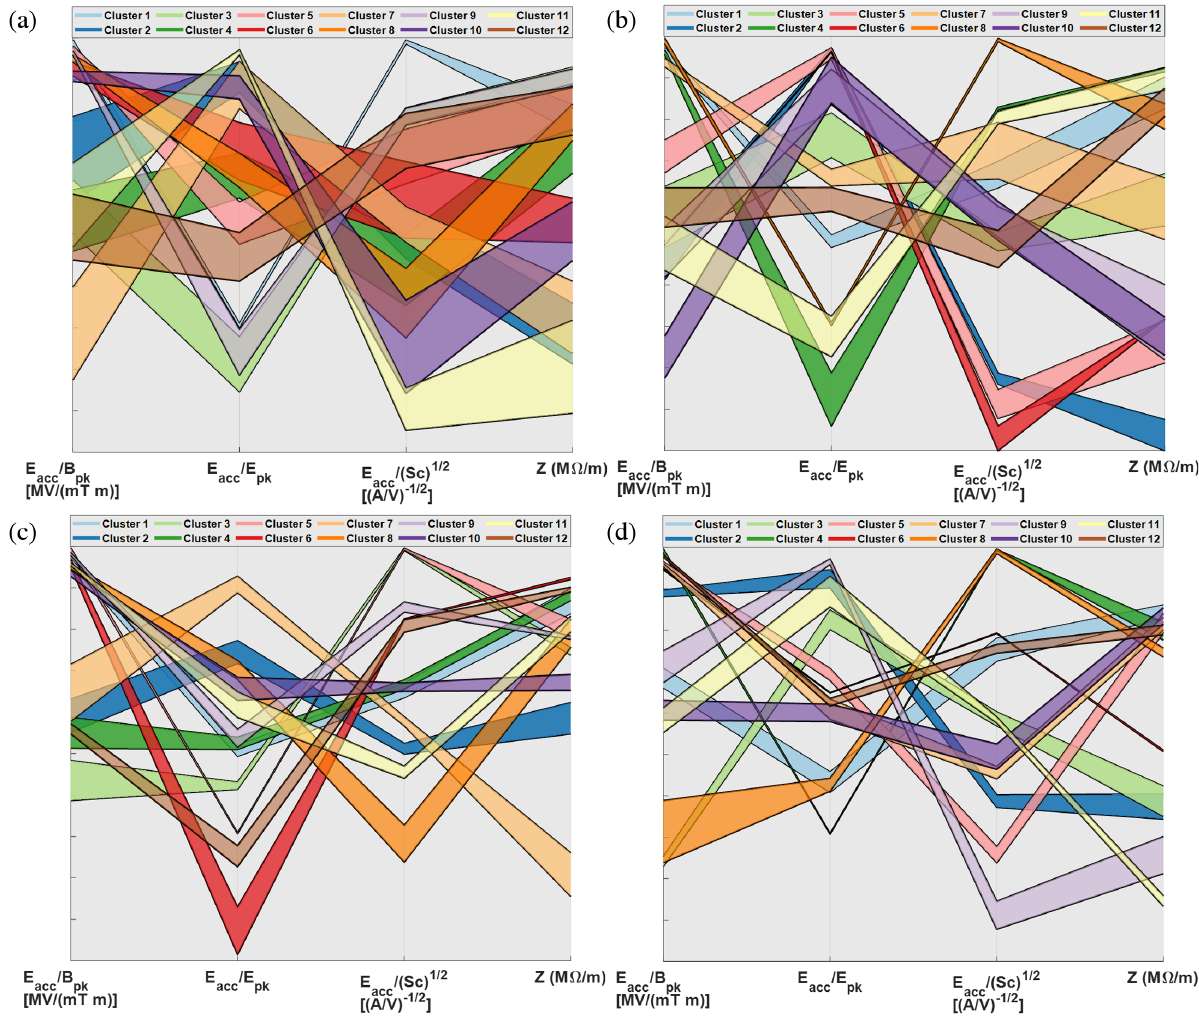
FIG. 16. PCP plots for four different clustering cases. Each line represents one cluster, and the width of the shaded regions represents the 25% and 75% percentiles within each cluster. (a) 12 clusters, (b) first 12 clusters from 24 clusters, (c) first 12 clusters from 36 clusters, and (d) first 12 clusters from 48